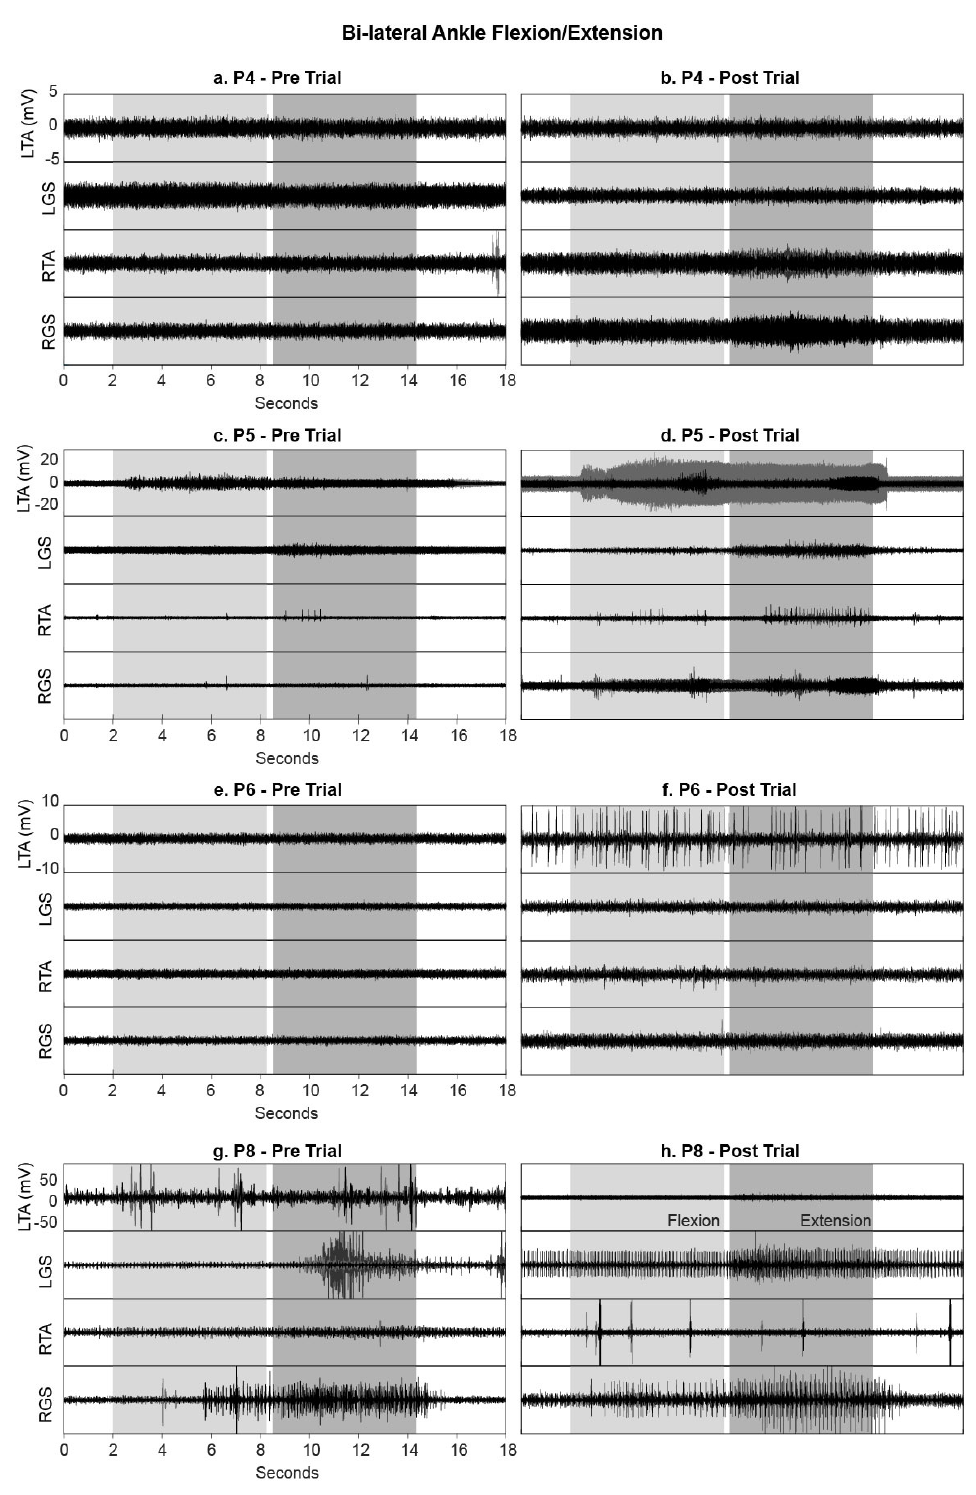
Figure 7. EMG activity recorded from the left (L) and right (R) Tibialis Anterior (TA) and Gastrocnemius (GS) during ankle flexion (light grey) and extension (dark grey) movements without tSCS, before and after the intervention. Data are shown for ( a , b ) P4, ( c , d ) P5, ( e , f ) P6 (STIM group) and ( g , h ) P8 (NON-STIM group); each movement was repeated three times, and EMG data from all three movements are